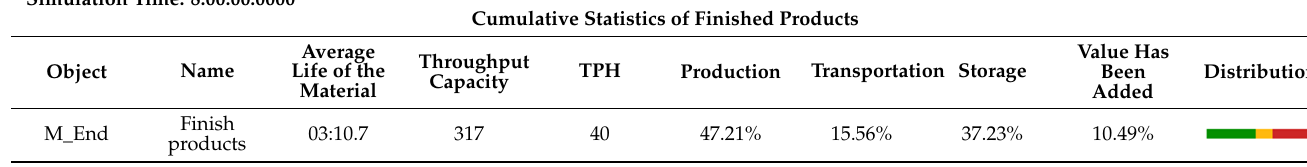
Table 12. Optimized performance of the production line.